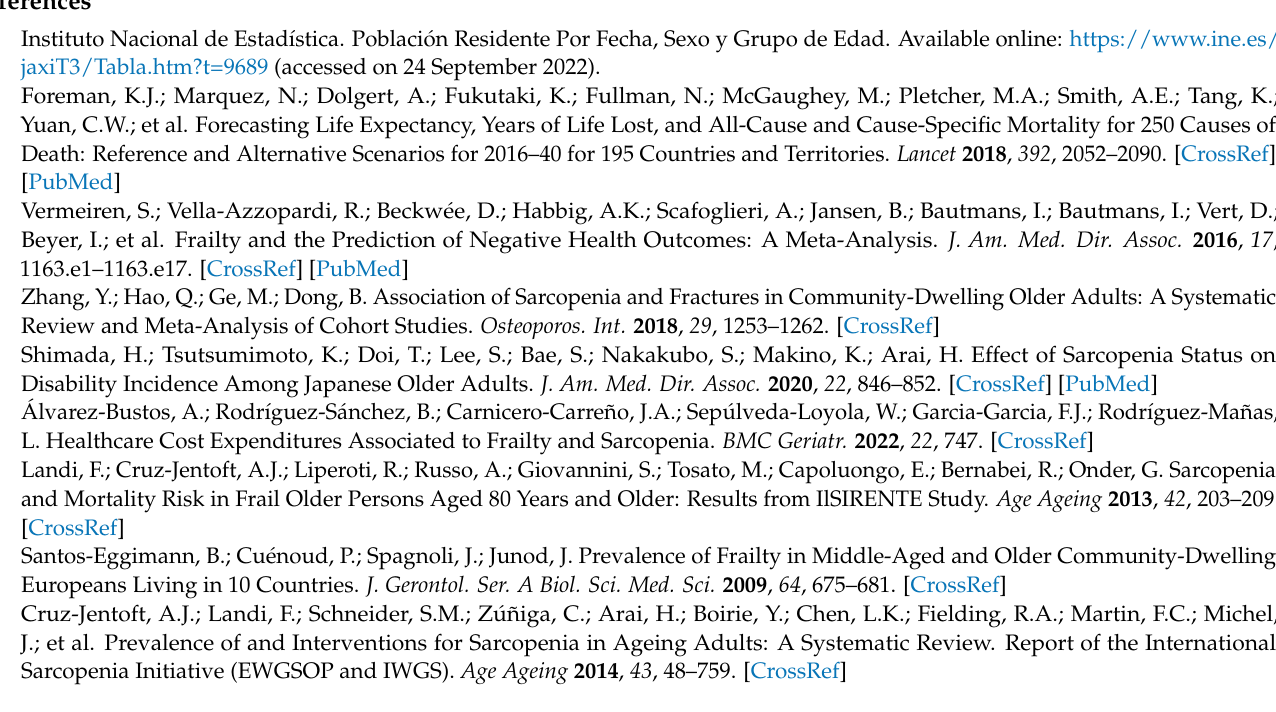
tween matched case–control pairs; Figure S2: Charlson index bar chart with error bars; Table S1: Comorbidities; Table S2: Geriatric syndromes; Table S3: Pearson correlations among total and LDL cholesterol and body mass index; Table S4: Body mass index, IL-6, and frailty; Table S5: Lifestyle habits and frailty; Table S6: Sarcopenia patients according to their BMI; Table S7: Body mass index and LDL and total